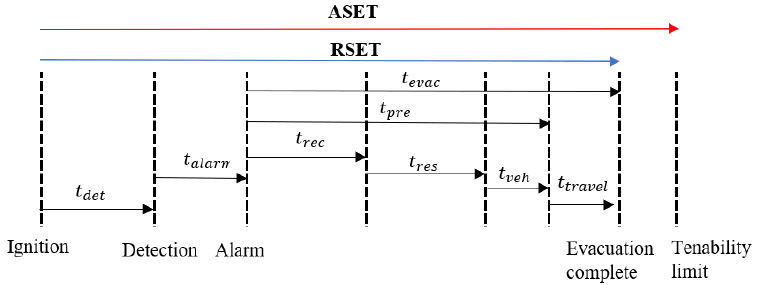
Figure 4. Four-stage evacuation